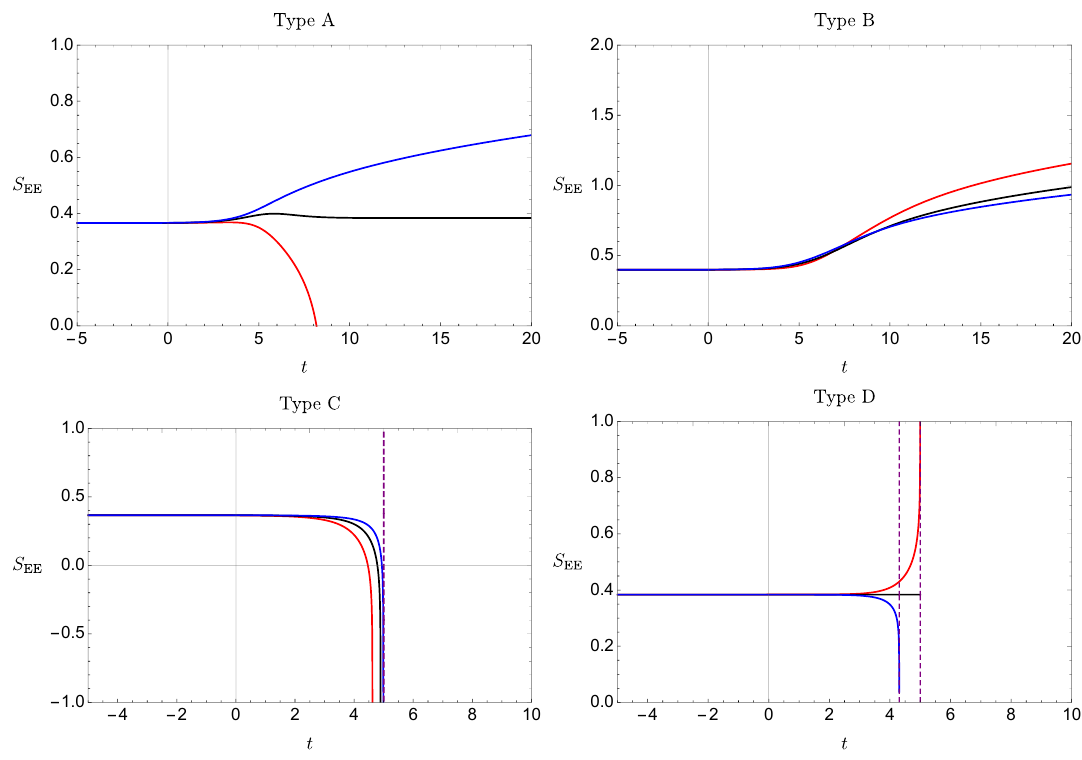
Figure 11 . Entanglement entropy for a static, semi-infinite interval A ∈ [ x 0 = 5 , + ∞ ] . The mapping functions p ( u ) for mirrors of type A, B, C, and D are respectively defined in eq. (2.14), eq. (2.18), eq. (4.5), and eq. (4.26), eq. (4.31). The red, black, and blue curves correspond to subclasses + , 0 , − , for which we have chosen n = 2 , n = 1 , and n = 1 in each 2